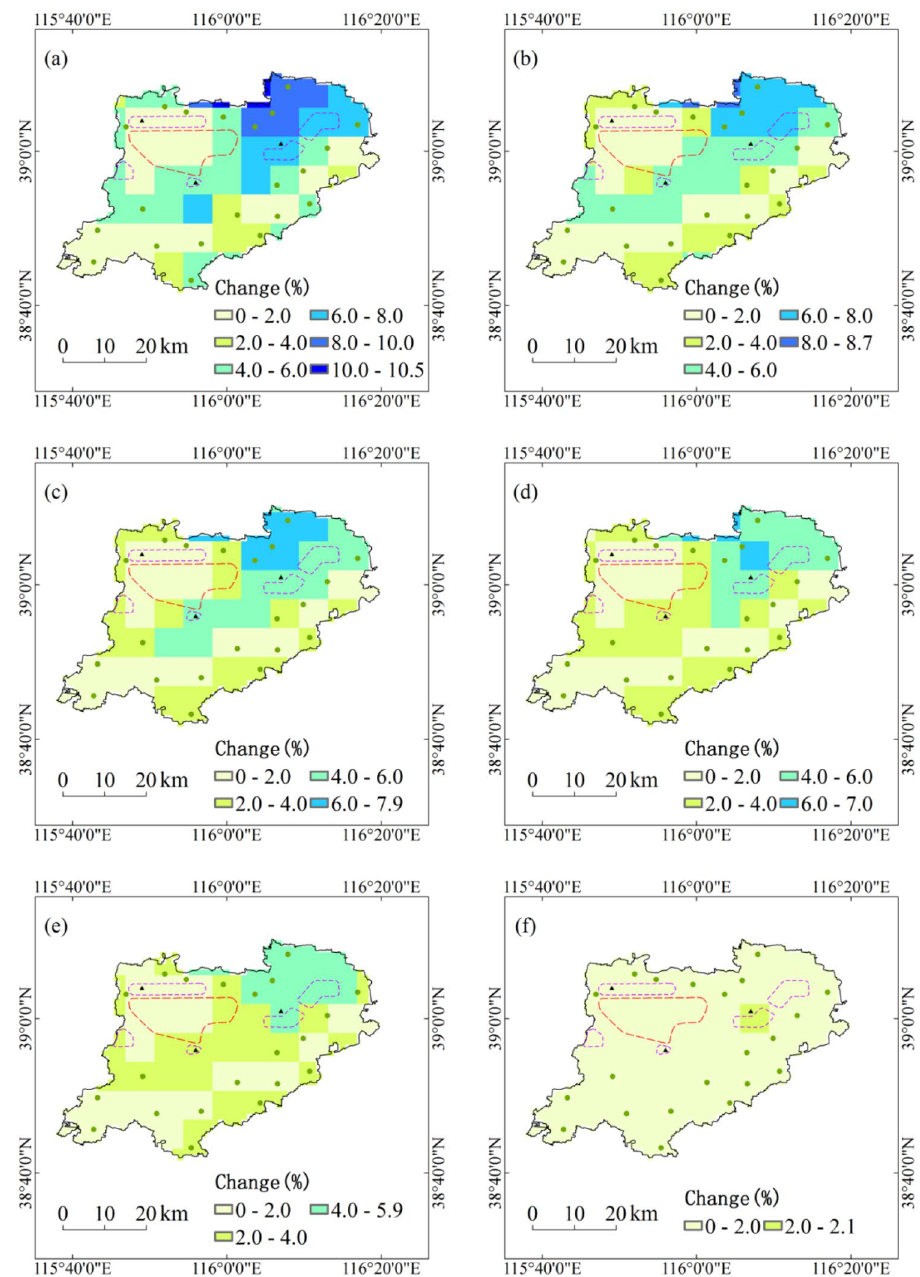
Figure 2. Projected changes of annual maximum daily precipitation with five return periods during the period 1991–2050. Maps show return periods of 10-year ( a ), 20-year ( b ), 30-year ( c ), 50-year ( d ) and 100-year ( e ) under RCP4.5 scenario and return periods of 10-year ( f ), 20-year ( g ), 30-year ( h ), 50-year ( i ) and 100-year ( j ) under RCP8.5 scenario. Maps generated in ArcGIS